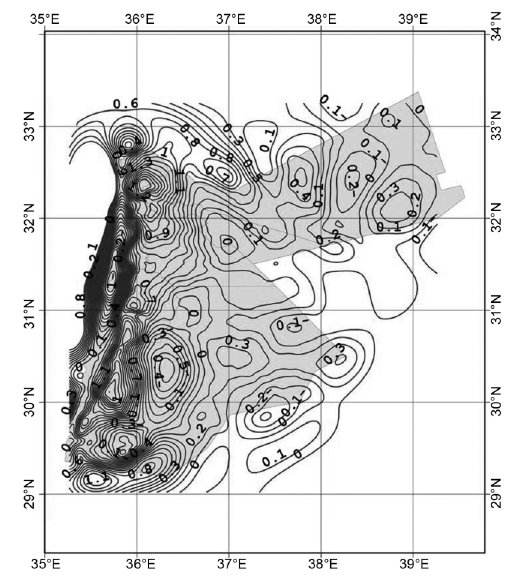
Fig. 5. The standard error associated with the «GeoJordan» (latitude and longitude in WGS84 and errors are expressed in